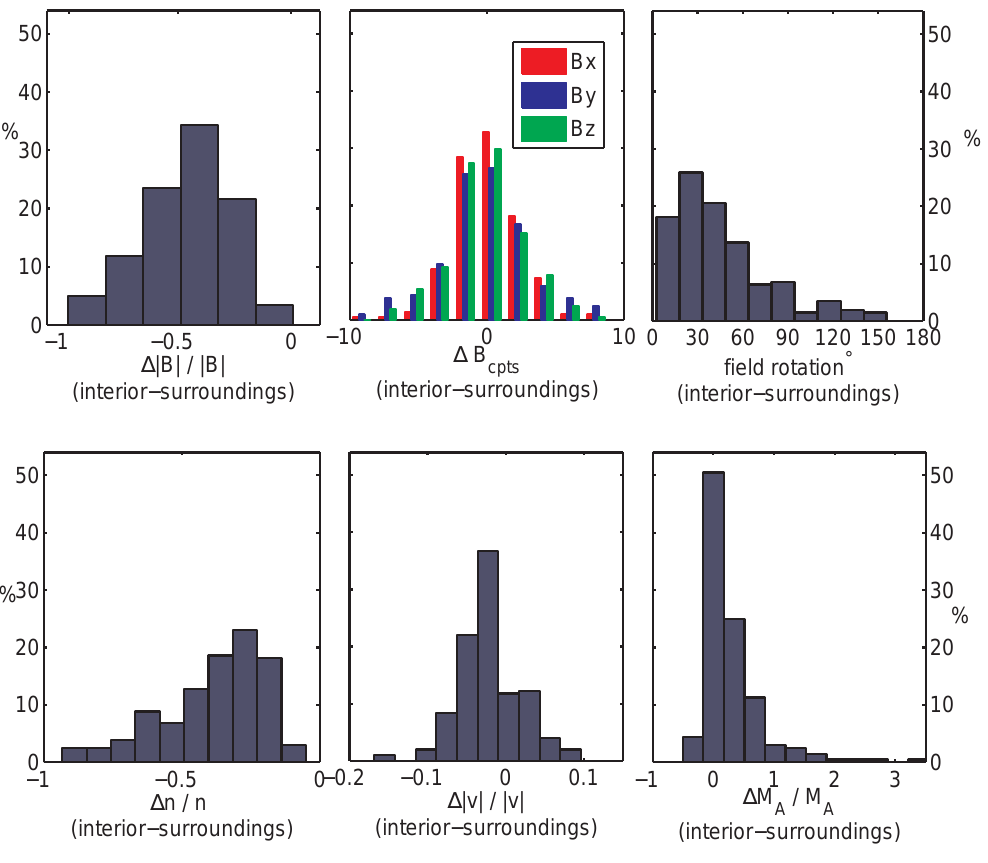
Fig. 11. Histograms of the differences between foreshock cavity centres and the surrounding plasma conditions in (clockwise from top left): magnetic field magnitude, GSE field components, field direction, Alfv´en Mach number, CIS bulk flow speed, and CIS thermal ion density. Apart from field rotation and components, changes in each parameter have been normalised by the ambient values.